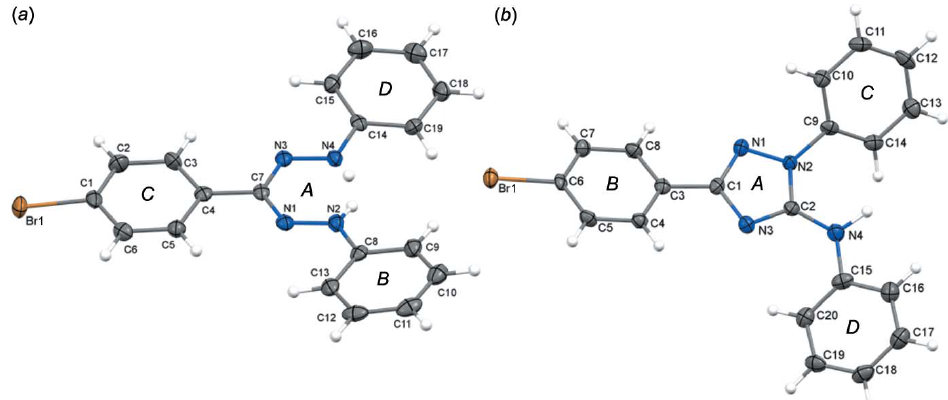
Figure 1 The molecular structures of ( a ) 1 and ( b ) 3 with displacement ellipsoids drawn at the 50% probability level.